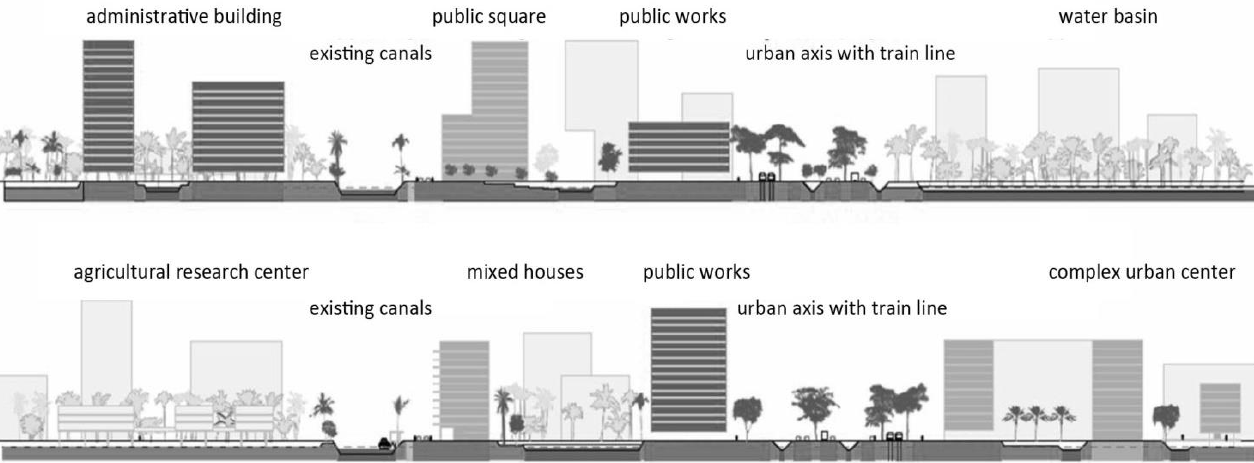
Figure 12. New EI is a combination of urban green patches and agricultural landscape through the network of canals in My Tho City. Source: Adapted from SISP.